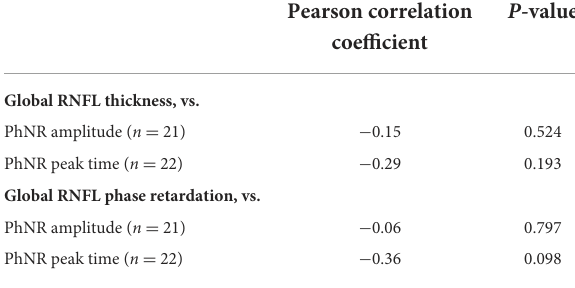
TABLE 5 Associations between retinal nerve fiber layer (RNFL) structural parameters and electroretinography functional parameters in case